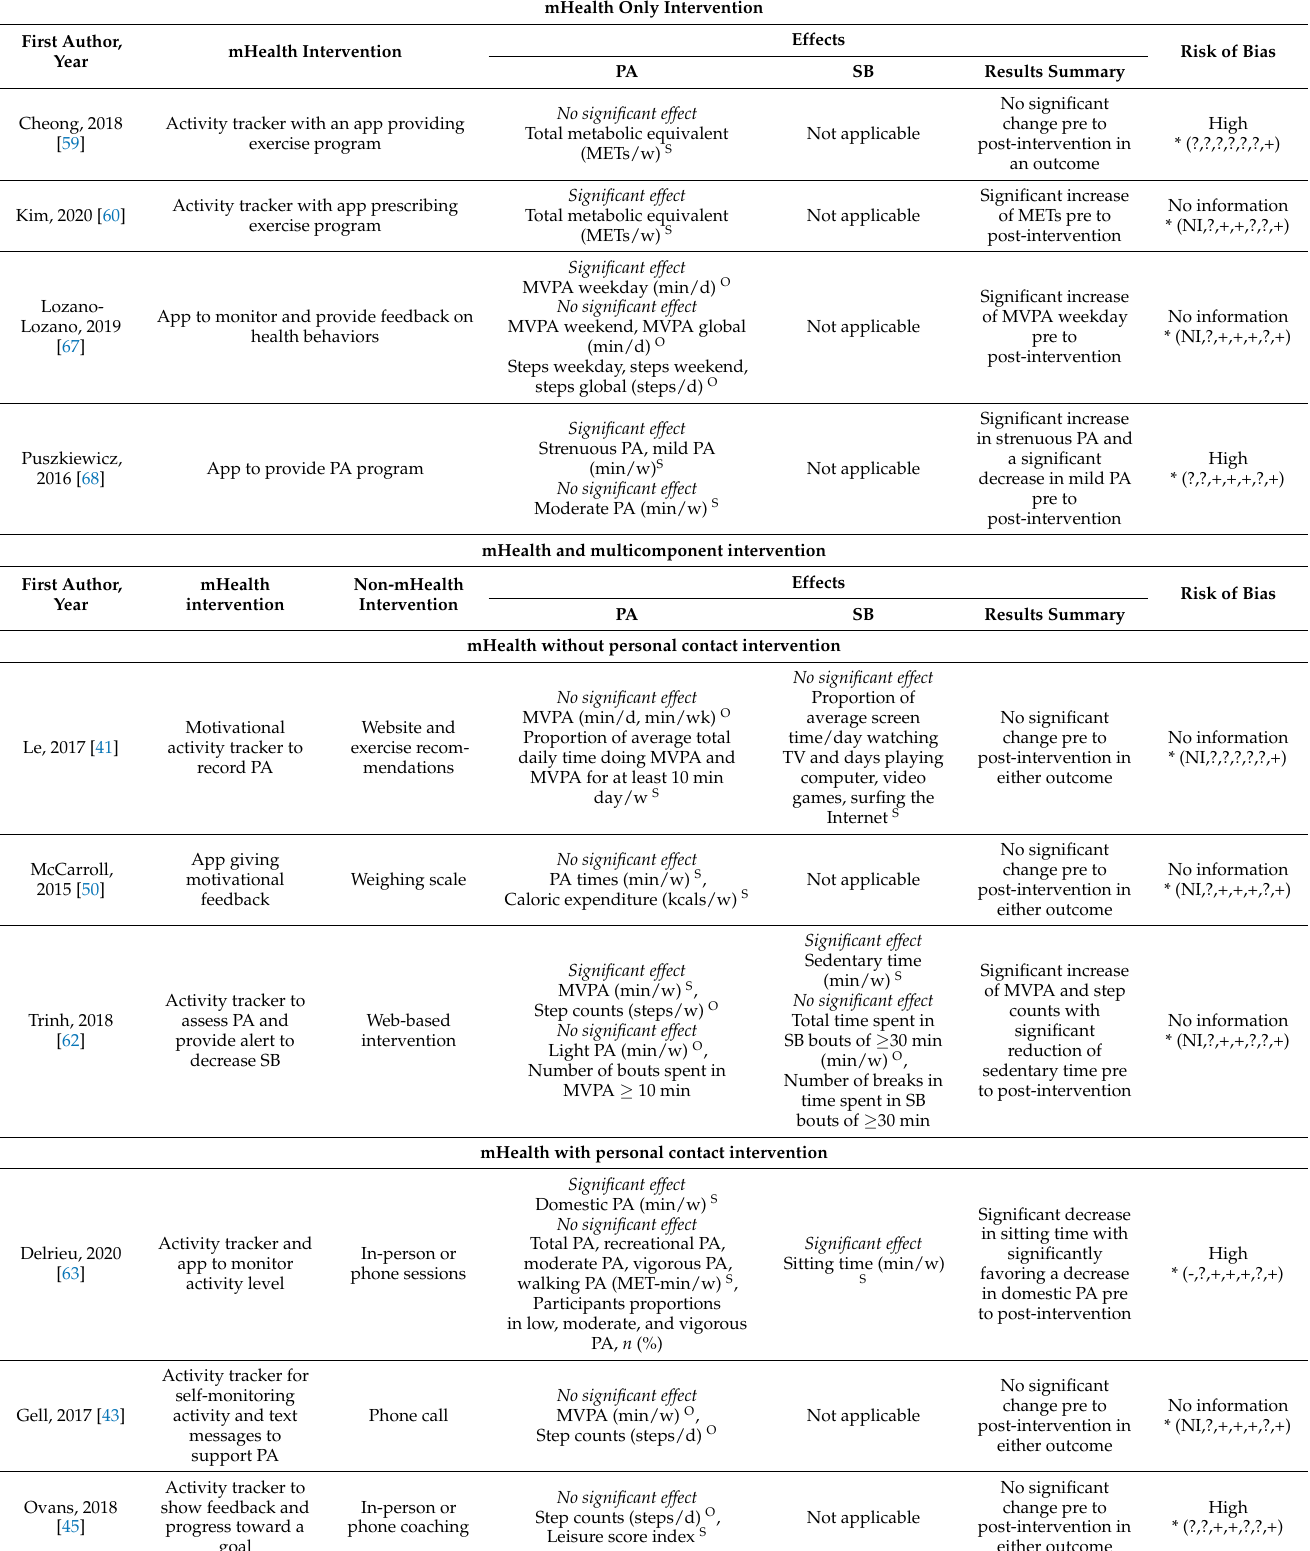
Table 3. Physical activity (PA) and sedentary behavior (SB) interventions effects were reported in non-controlled